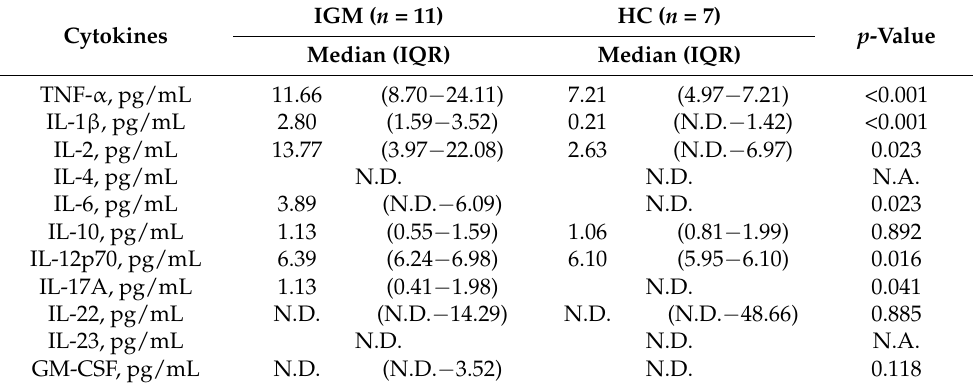
Table 2. The comparison of serum cytokine levels of patients with idiopathic granulomatous mastitis and healthy controls.